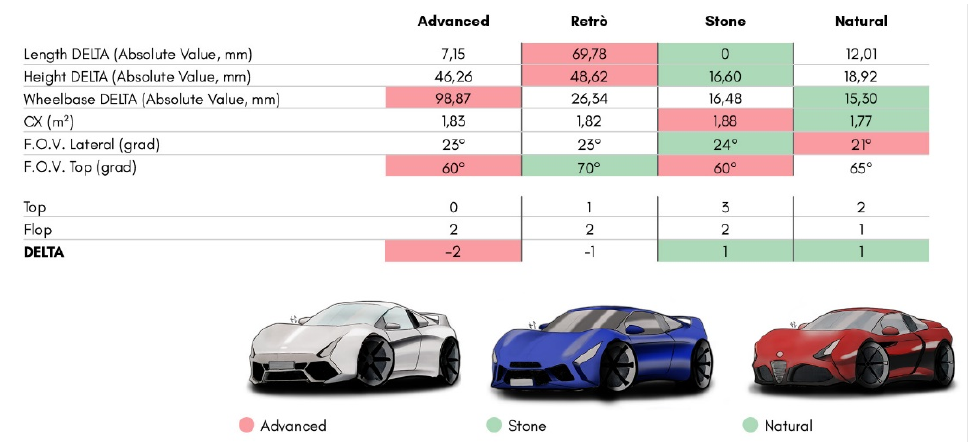
Figure 20. Stylistic Analysis Benchmarking.